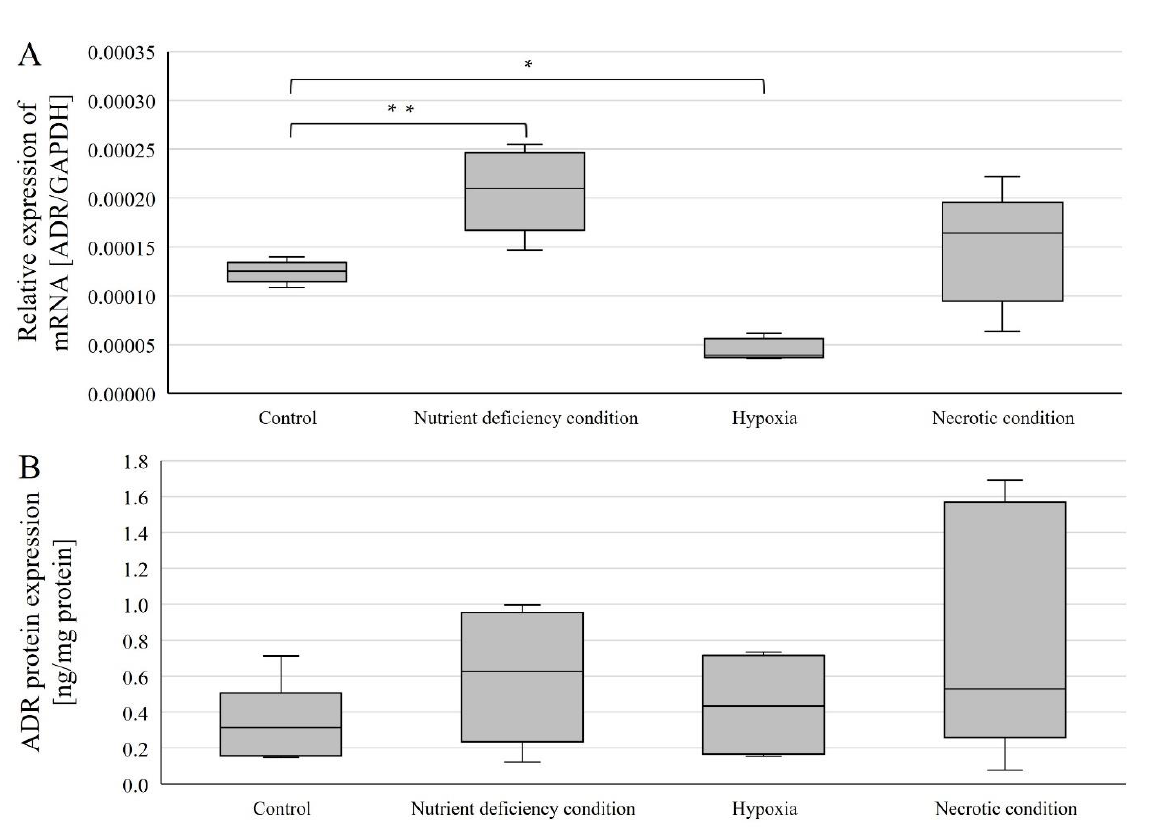
Figure 3. Expression of genes ( A ) and AR protein ( B ) in U87 cells cultured under different conditions. Data are representative of each group cultured in control, nutrient-deficient, hypoxic, and necrotic conditions. Statistical analysis was performed using t -test, ** p < 0.0000005, * p < 0.005.